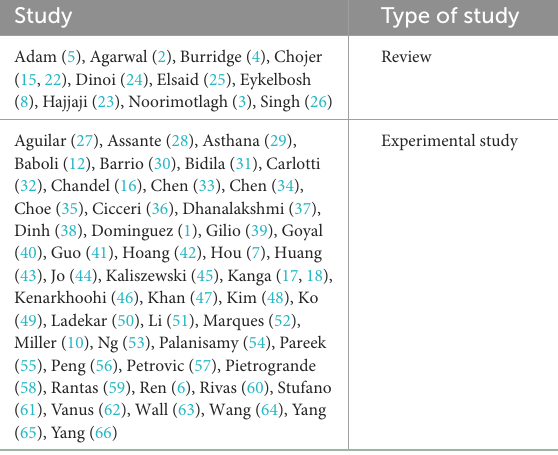
TABLE 2 Classification of study type.